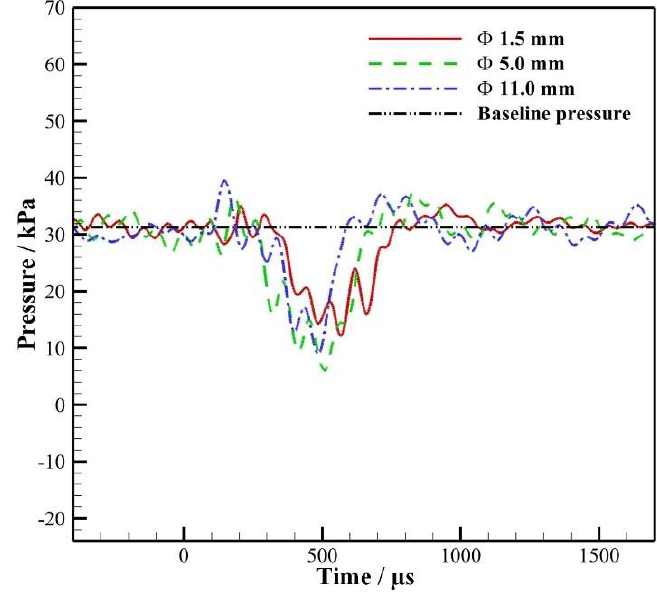
Figure 9. Change curves of ramp pressure with different exit diameter.